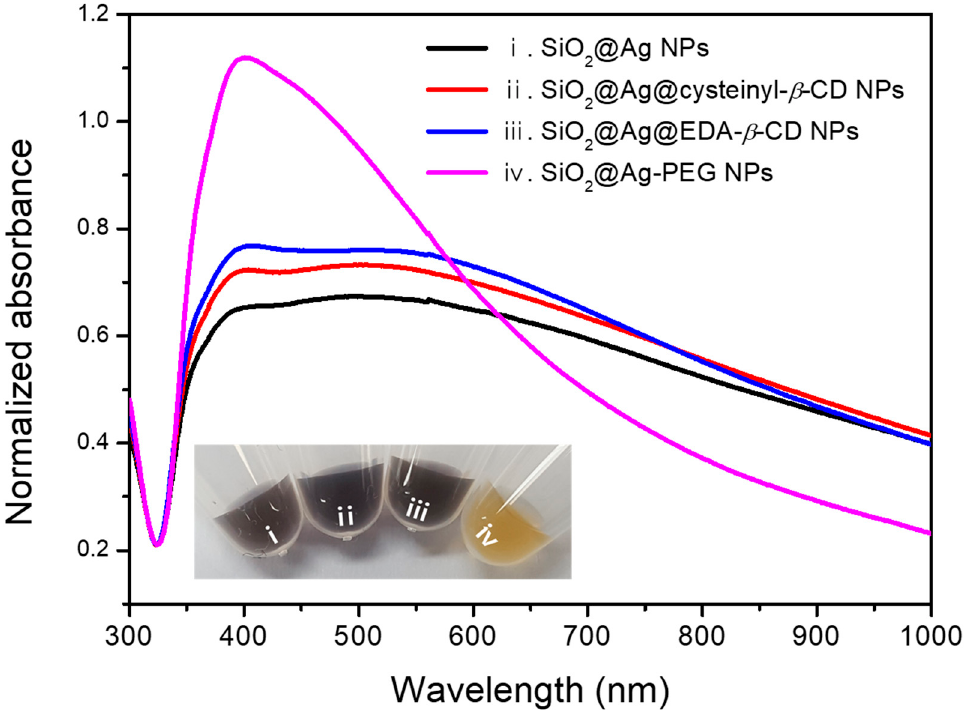
Figure 3. UV-Vis spectra for SiO 2 @Ag NPs, SiO 2 @Ag@cysteinyl- β -CD NPs, SiO 2 @Ag@EDA- β -CD NPs, Figure 3. UV ‐ Vis spectra for SiO 2 @Ag NPs, SiO 2 @Ag@cysteinyl ‐ β ‐ CD NPs, SiO 2 @Ag@EDA ‐ β ‐ CD NPs, and SiO 2 @Ag-PEG NPs. (i) SiO 2 @Ag NPs, (ii) SiO 2 @Ag@cysteinyl- β -CD NPs, (iii) SiO 2 @Ag@EDA- β -CD and SiO 2 @Ag ‐ PEG NPs. i) SiO 2 @Ag NPs, ii) SiO 2 @Ag@cysteinyl ‐ β ‐ CD NPs, iii) SiO 2 @Ag@EDA ‐ β ‐ CD NPs, and (iv) SiO 2 @Ag-PEG NPs. (Inset: Photograph of synthesized NP solutions using four kinds of NPs, and iv) SiO 2 @Ag ‐ PEG NPs. (Inset: Photograph of synthesized NP solutions using four kinds of ligands, showing the color ligands, showing the color change).